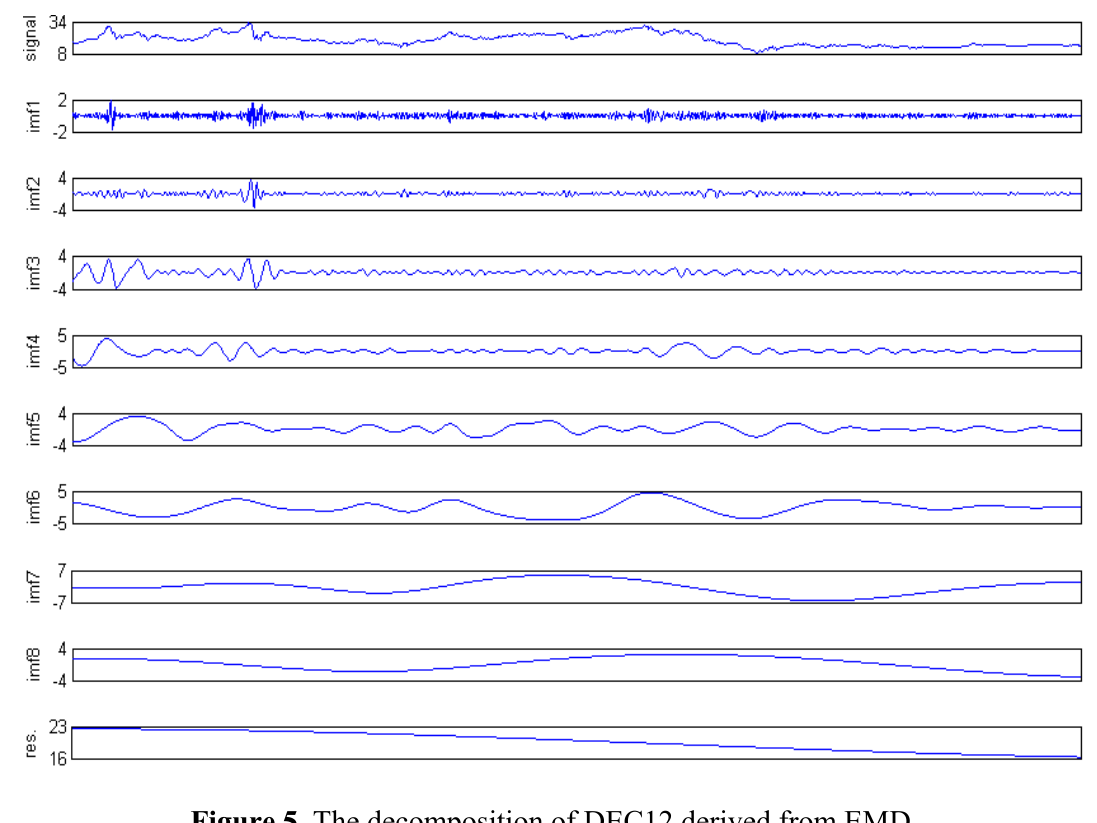
Figure 4. The decomposition of DEC10 derived from EMD.